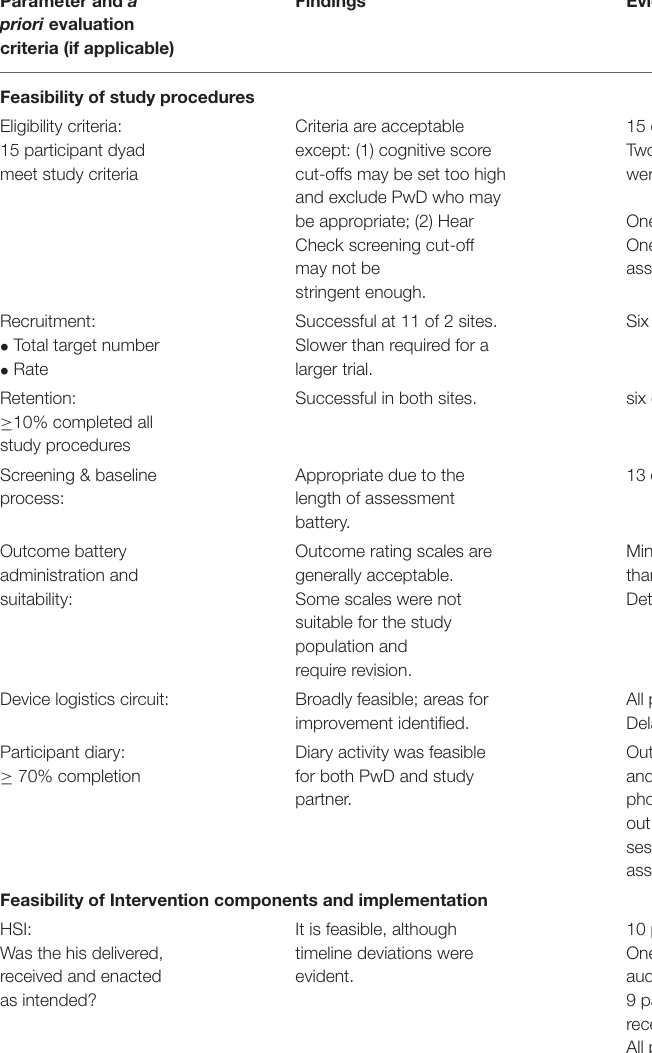
TABLE 5 | Feasibility of trial procedures. Parameter and a priori evaluation criteria (if applicable) Feasibility of study